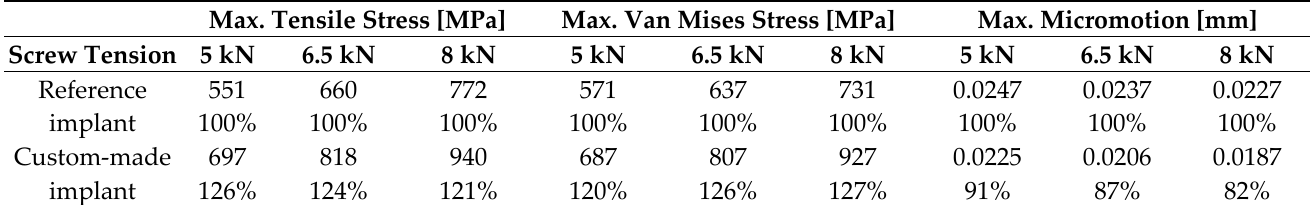
Table 3. FEA results of custom-made implant